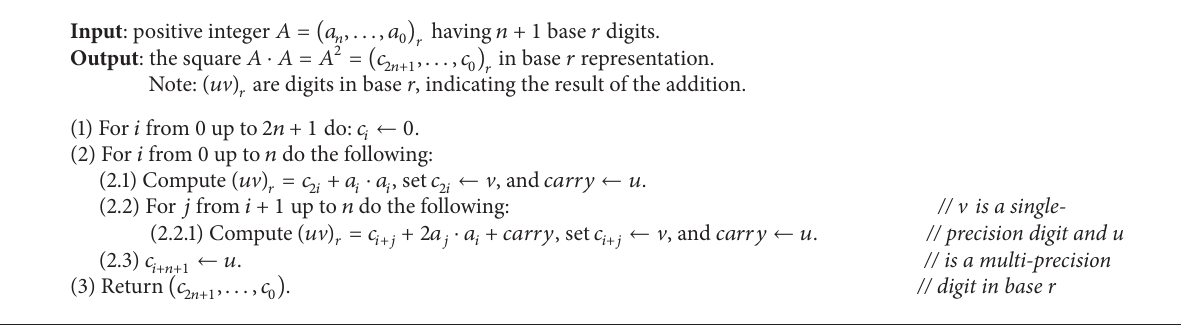
Algorithm 3: Multiple-precision classical squaring, SQ( 𝐴 ).